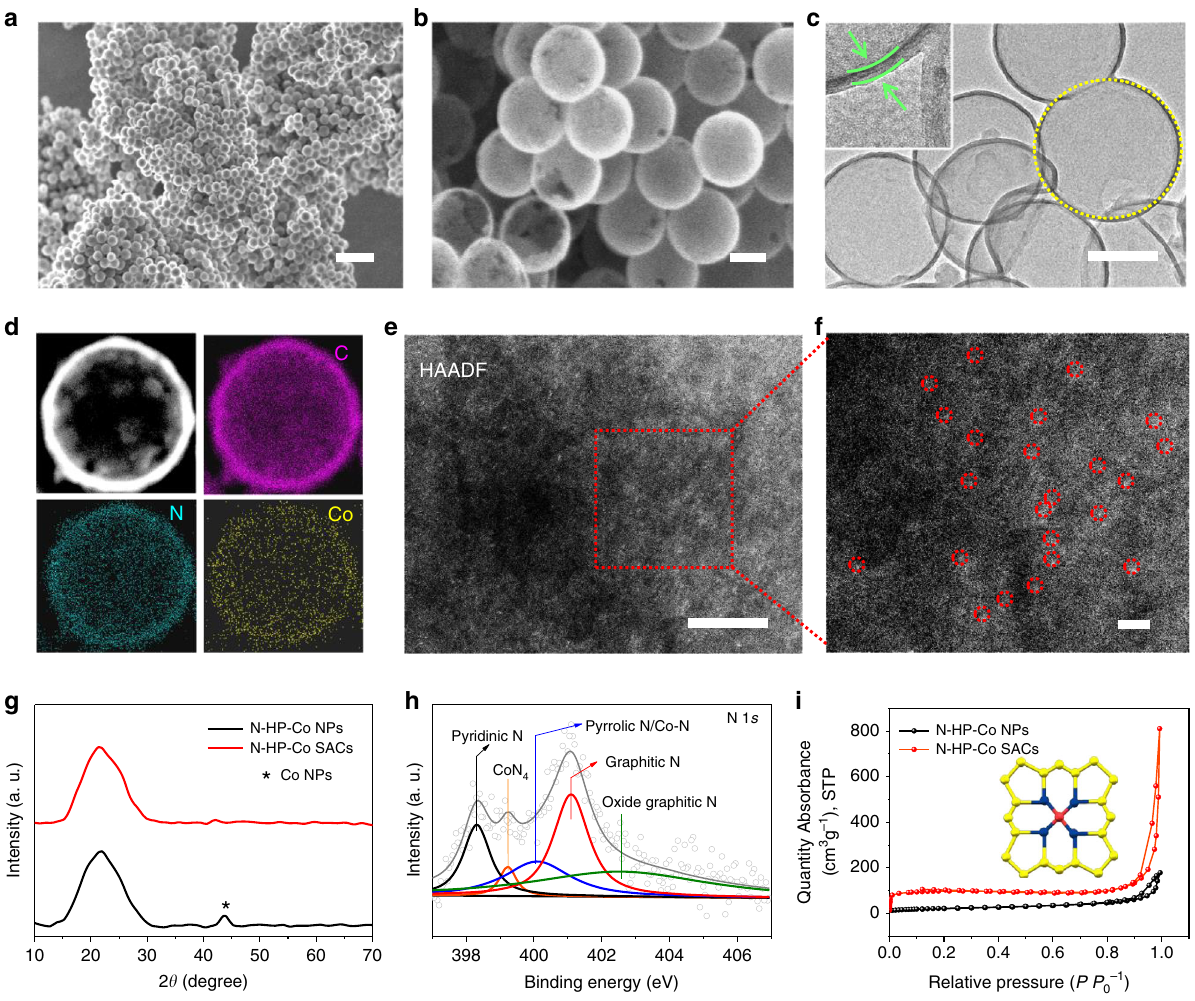
Fig. 2 Characterization of N-HP-Co SACs. SEM images of N-HP-Co SACs, 1 μ m in ( a ), 200 nm in ( b ); c TEM image of N-HP-Co SACs. d HAADF-STEM image, 50 nm in ( d ); and the corresponding elemental maps. e HAADF-STEM image, 5 nm in ( e ), f enlarged image of N-HP-Co SACs, 2 nm in ( f ); g PXRD graphs of N-HP-Co NPs and Co-SACs. h High-resolution N 1 s XPS spectra of N-HP-Co SACs. i N 2 adsorption-desorption isotherms of N-HP-Co NPs and Co SACs at 77 K. BET: 80.5cm 3 g − 1 with N-HP-Co NPs; 312.3 cm 3 g − 1 with N-HP-Co